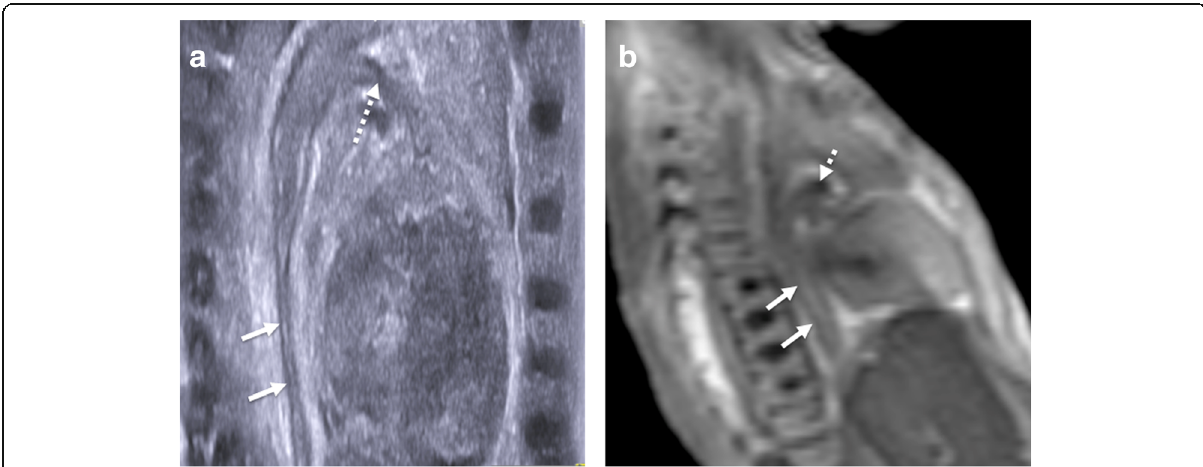
Fig. 11 Paired sagittal midline imaging of the chest, in a 20-week gestational-aged foetus obtained approximately 1 week after death. The postmortem ultrasound imaging ( a ) and T2-weighted MRI imaging at 1.5 T ( b ) both clearly demonstrate the usual appearances of haemostasis and collapse of the descending aorta (solid white arrows) and also prominent patent ductus arteriosus (dotted